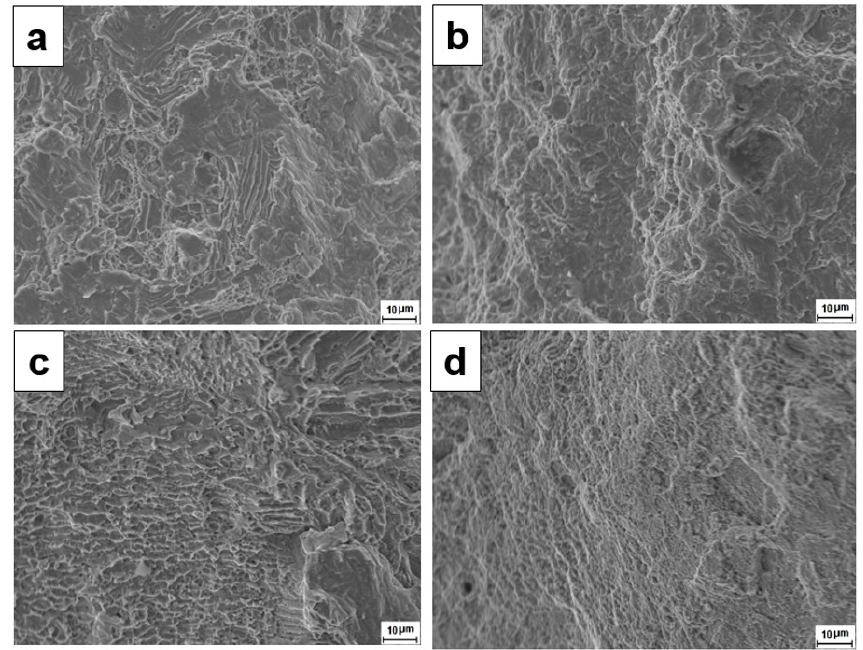
Figure 11. SEM fractographs of ( a ) as-cast BM; ( b ) heat treated BM; ( c ) as-deposited WM; and ( d ) heat treated WM.